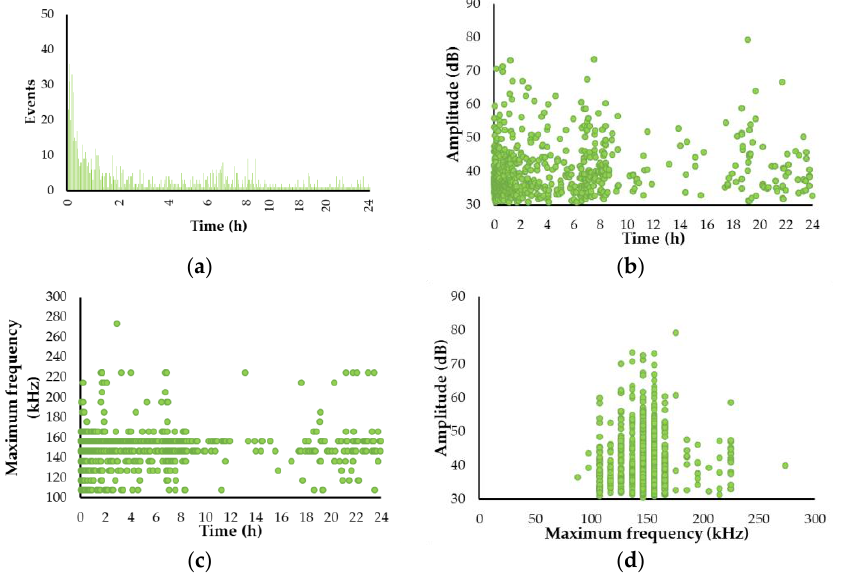
Buildings 2022 , 12 , x FOR PEER REVIEW Figure 15. AE results of termites inoculated in the laboratory test. ( a ) events vs. time; ( b ) amplitude vs. time; ( c ) maximum frequency vs. time; ( d ) maximum frequency vs. amplitude.